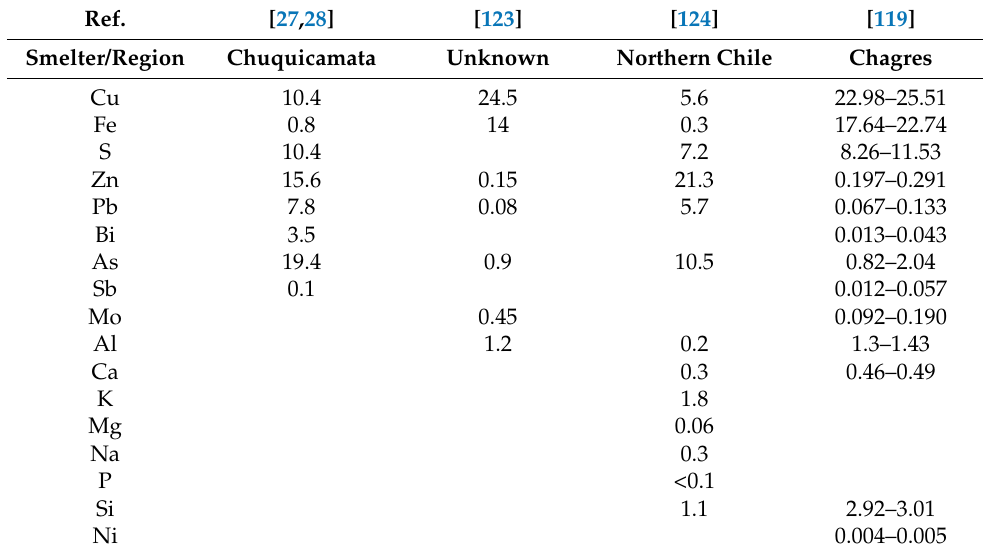
Table 9. Chemical composition (%) of flue dust from Chilean smelters/converters.